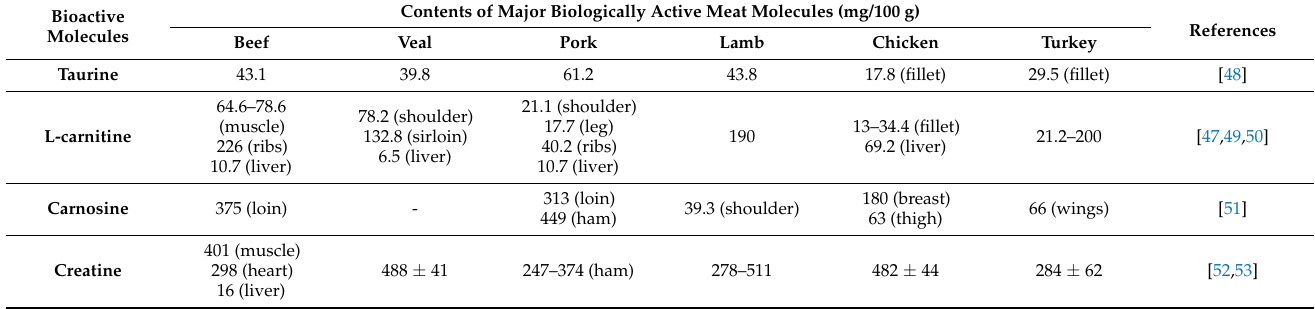
Table 2. Contents of major biologically active meat molecules (mg/100 g) in raw meat cuts of different animal